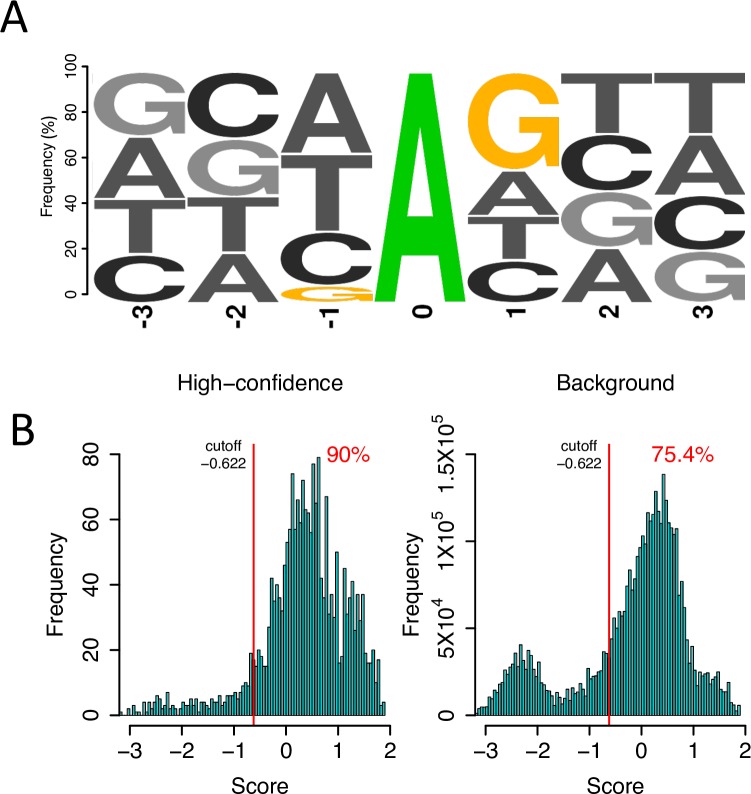
The effect of local nucleotide contexts on editing in brains of D. melanogaster.(A) A 7-mer motif centered with the high-confidence editing sites. (B) The score cutoff that specified the top 90% quantile of the high-confidence editing sites. (-0.622) corresponds to the top 75.4% of all the 7-mer sequences centered with adenosine in the genes with editing events.